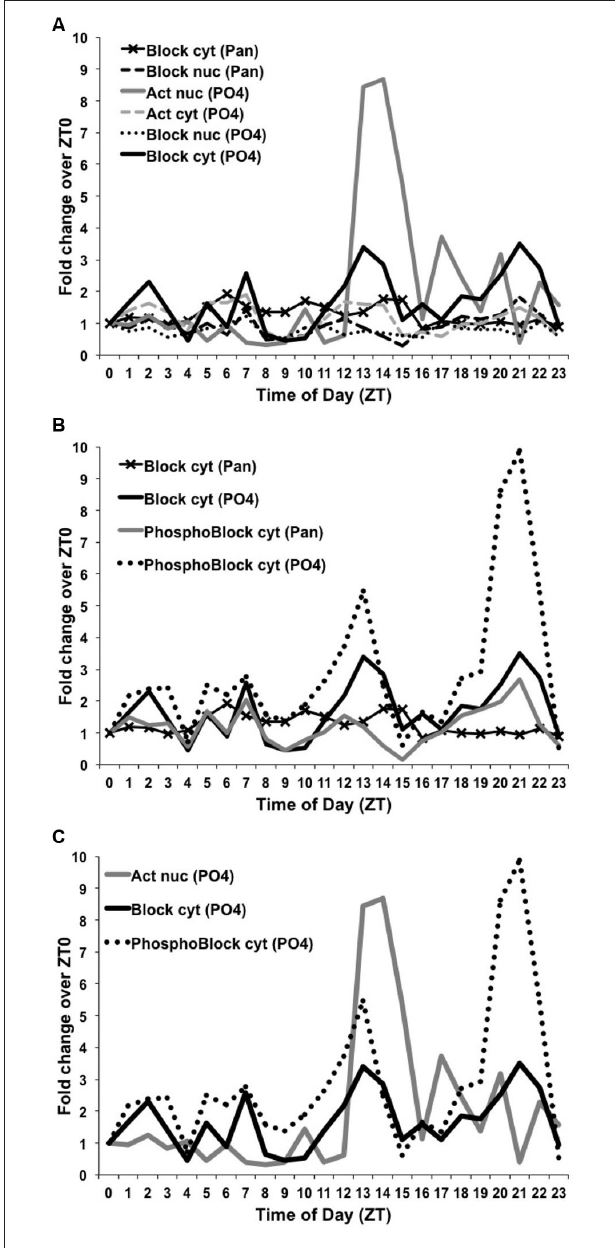
FIGURE 7 | Levels of dCREB2 protein isoforms oscillate through the day/night. Quantification of Western blot images from samples generated by wild-type flies collected each hour across a day (see Figures 5 and 6 ). Each dCREB2 band was normalized to the appropriate loading control across time points. Data are presented as fold changes of the normalized values for each isoform compared to the normalized ZT0 value for that isoform. p35 Activator, p40 Blocker, and hyperphosphorylated p40+ Blocker dCREB2 species (labeled “Act”, “Block”, and “PhosphoBlock”, respectively) are presented for both nuclear (nuc) and cytoplasmic (cyt) samples. (A) Illustrates the nuclear increase in Activator during the early night (solid gray line) and fluctuating levels of cytoplasmic Blocker, which show multiple peaks and troughs (solid black line). (B) Highlights the strong early- and late-night peaks in cytoplasmic, hyperphosphorylated Blocker species (dotted black line). (C) Three dCREB2 species have time points with greater than 2-fold increases over ZT0